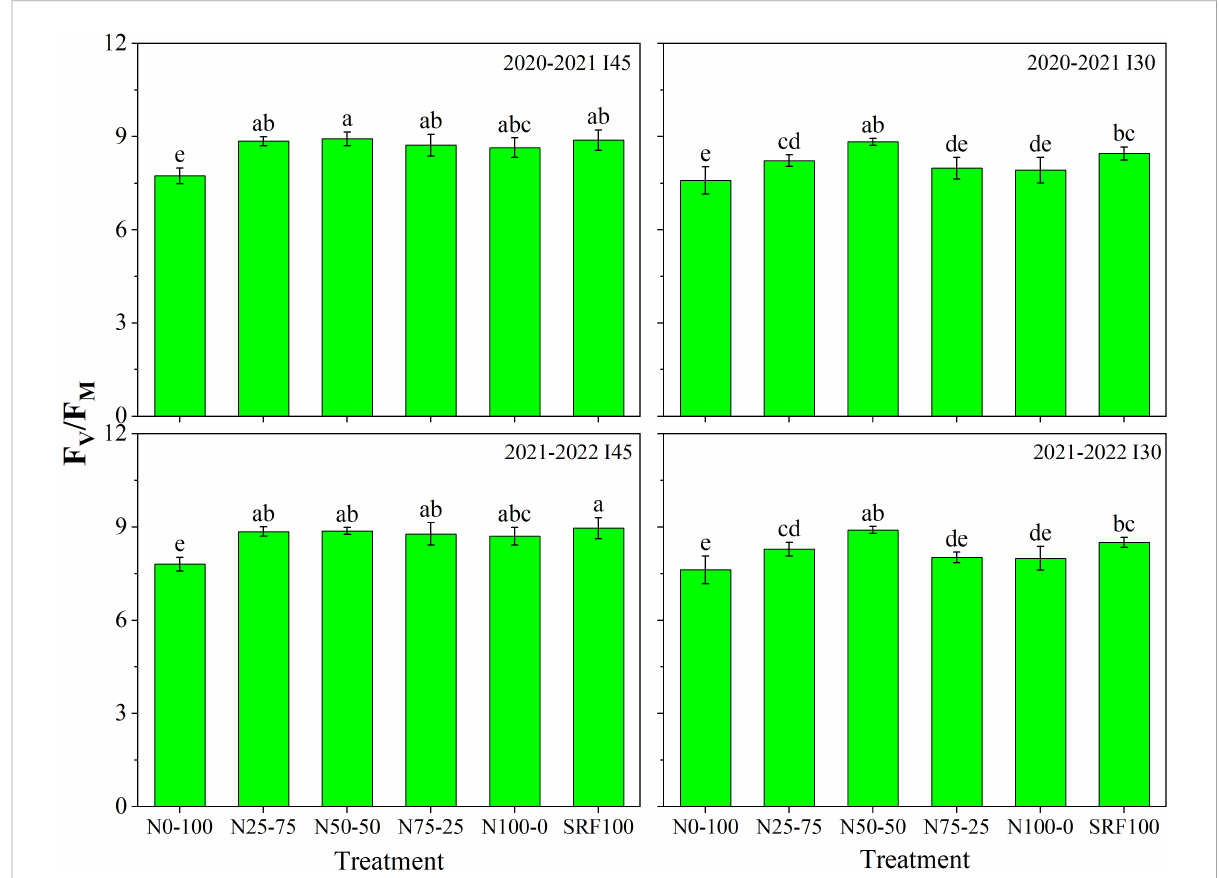
FIGURE 6 Effects of different irrigation scheduling and nitrogen application modes on the maximal photochemical ef fi ciency of photosystem II (F V /F M ) during 2020-2021 and 2021-2022 winter wheat-growing seasons. Each value indicates the mean of three replicates ± standard deviation and the different letters on top of the error bar represent a signi fi cant difference at P <